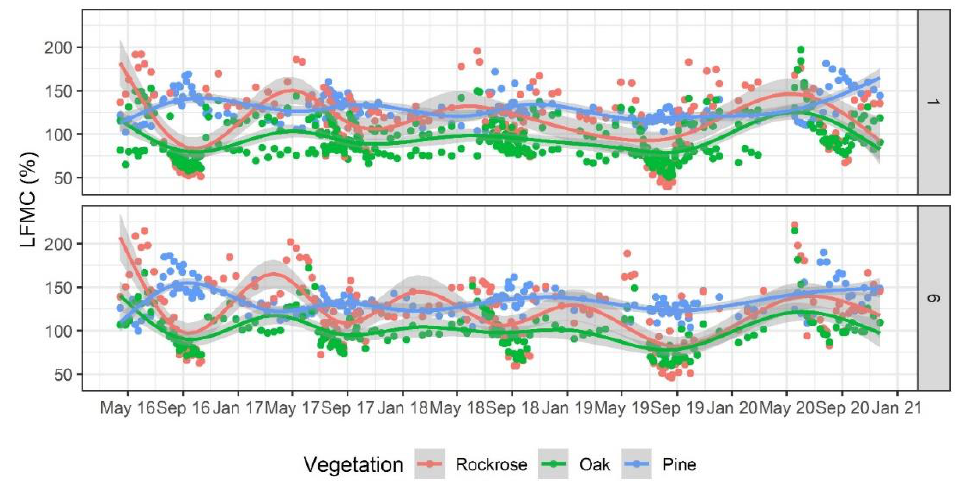
Figure 3. Temporal trends for live fuel moisture content (LFMC) by species at locations 1 and 6 (all species present). Lines show general additive models with integrated smoothness estimation. Grey shades show confidence (0.95) interval around the smooth.